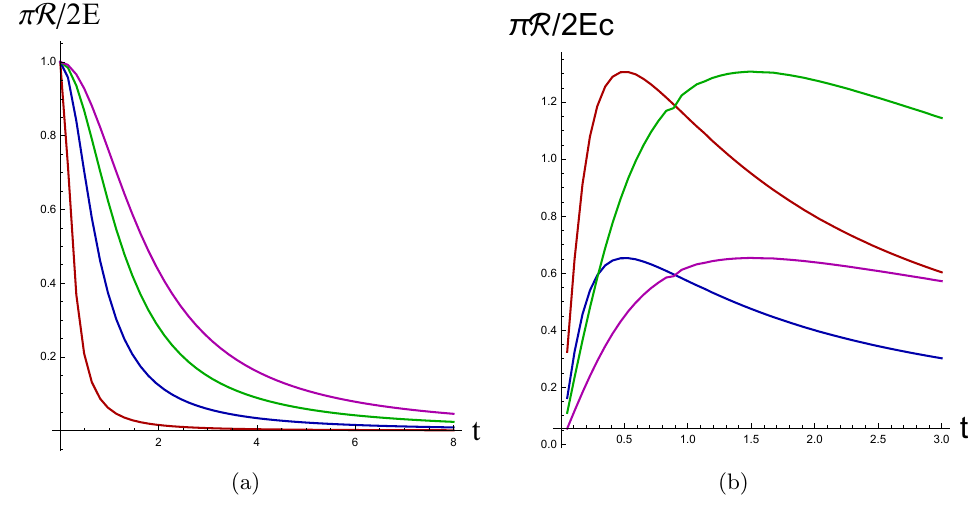
Figure 9 . On the left plot, we present normalized complexi(cid:12)cation rate (cid:25) R = 2 E calculated within the CA duality. Di(cid:11)erent curves correspond to di(cid:11)erent values of (cid:11) = 0 : 25 ; 0 : 75 ; 1 : 25 ; 1 : 75 from the left to the right. On the right plot, the ratio (cid:25) R = (2 Ec ) calculated for the total system within the CV duality is shown, c = 24 h=M . The red and the blue curves have (cid:11) = 0 : 25, while the green and the magenta ones | (cid:11) = 0 : 75. M = 0 : 1 for all curves. The top curves, violating the Lloyd bound, correpond to insertion of a lighter operator dimension, h = 0 : 1, while the bottom ones | to heavier operator with h = 0 :